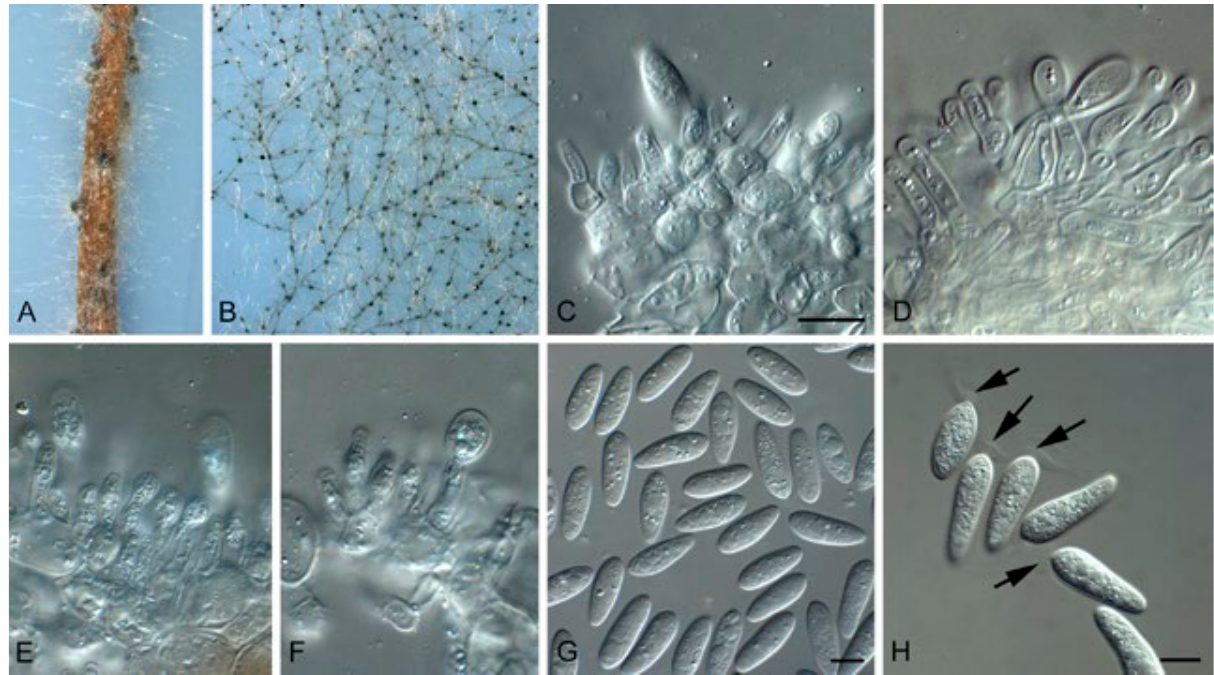
Figure 5. Macrophomina pseudophaseolina (CPC 21417). Pycnidia forming on pine needle agar. B. Sclerotia on tap water agar. C–F. Conidiogenous cells. G, H. Macroconidia with apical appendages (arrows). Scale bars = 10